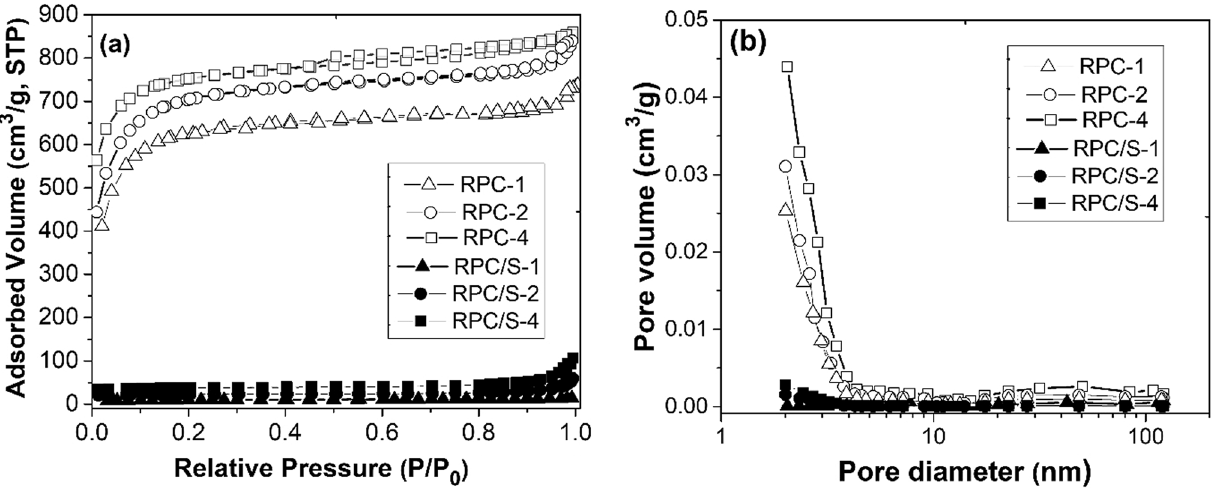
Fig. 3 a Nitrogen adsorption/desorption isotherms (measured at 77 K) and b Cumulative pore size distribution (PSD) of the RPC and RPC/S samples